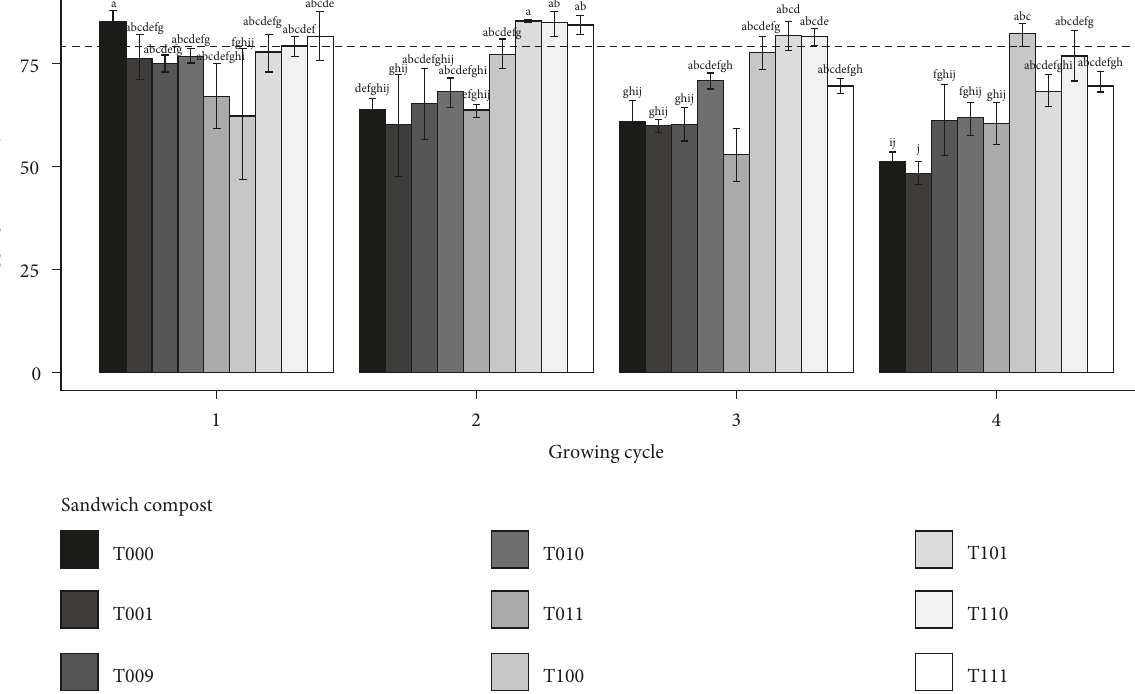
Figure 4: Effect of the growing cycle and Sandwich compost amendments on soil aggregate stability (%). Mean ± standard error with different letters is significantly different at P < 0 . 05 when using